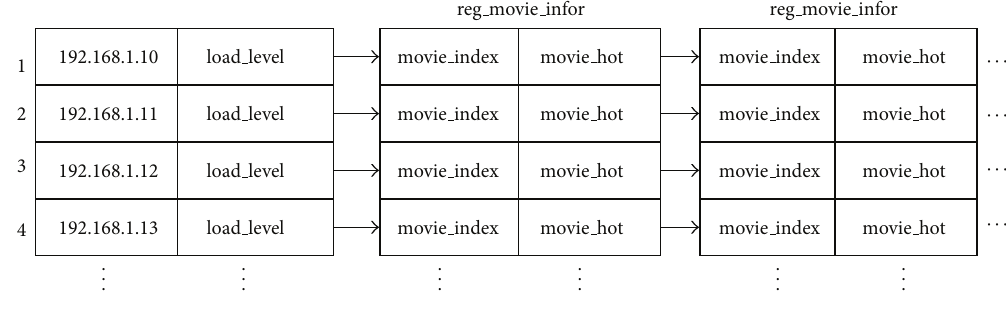
Figure 3: Server addresses